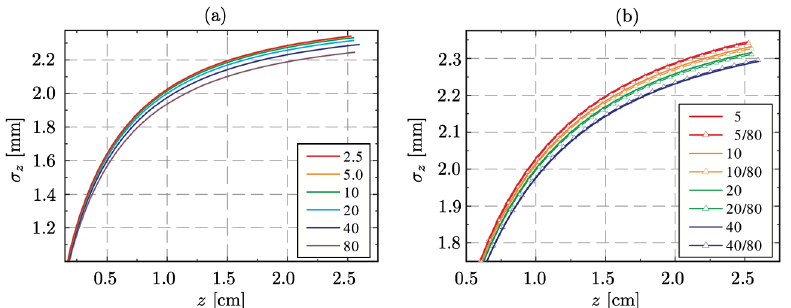
FIG. 12. Computed RMS bunch length vs longitudinal grid step size. In (a) equidistant grids with different grid step sizes were used. In (b) the equidistant grid with a step size of 80 (cid:3) m was statically refined within the first cm from the cathode. The step sizes given in the legend are in units of (cid:3) m